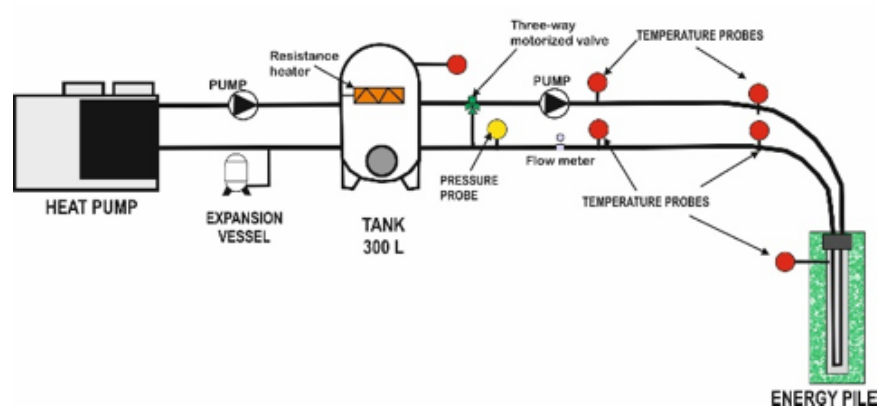
Figure 3. Thermal loads generating